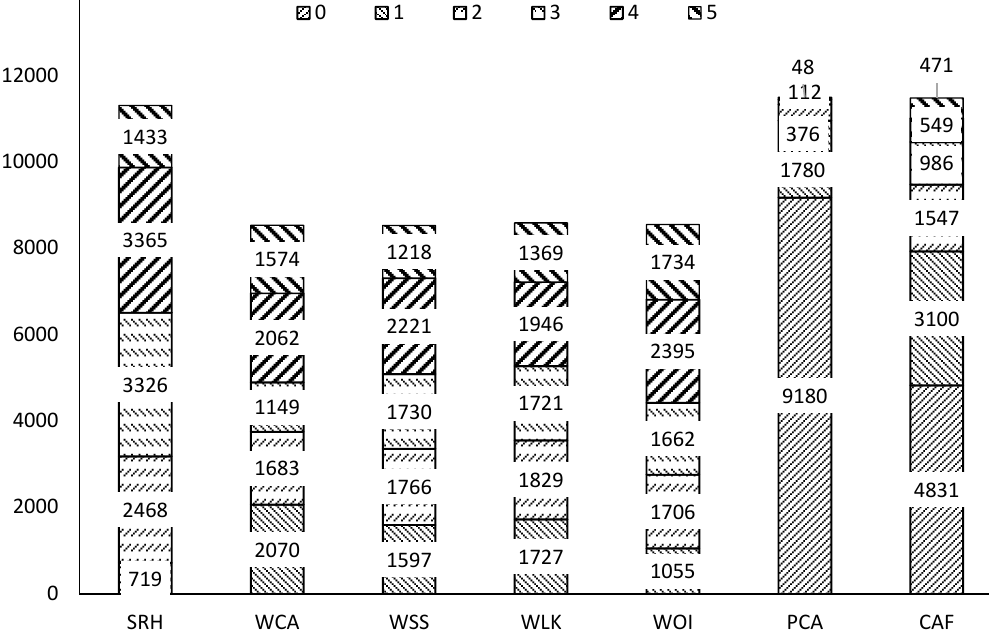
Table 4. Model maximum likelihood estimation results.